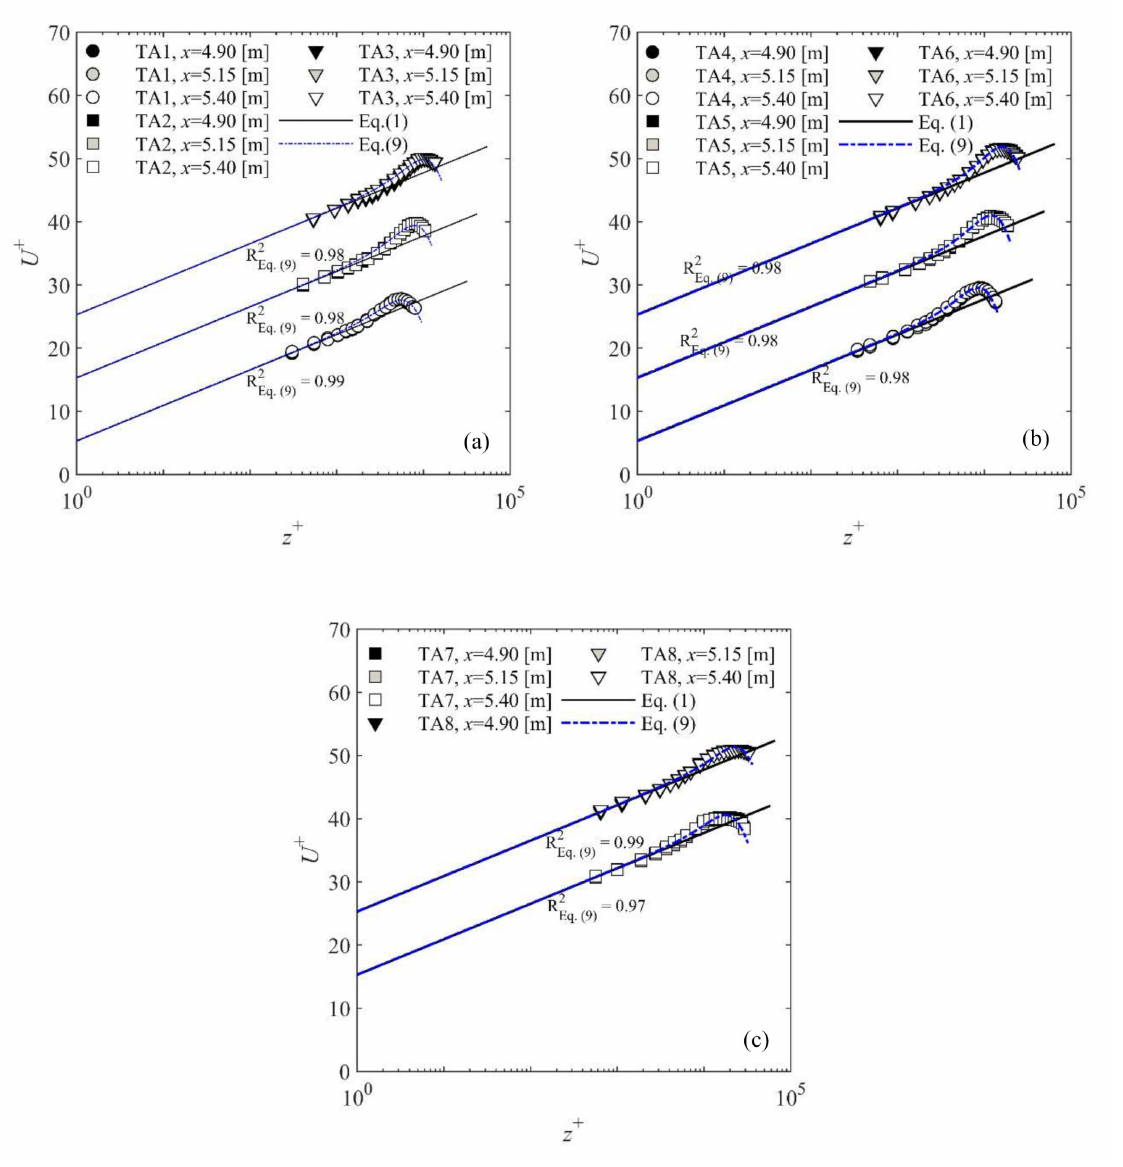
Figure 5. Mean streamwise velocity profiles together with log-law (Equation (1)) and modified log-wake-law (Equation (9)) fits for ( a ) TA1–TA3, ( b ) TA4–TA6, ( c ) TA7–TA8 in all cross-sections at y / h =